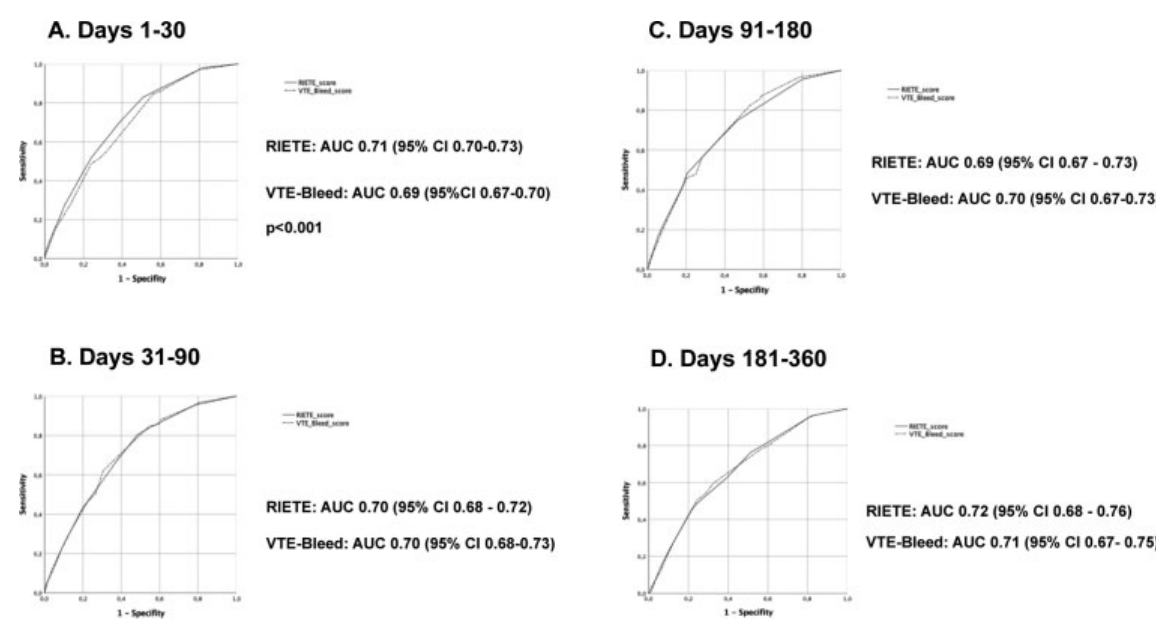
Fig. 1 Receiver operating characteristic (ROC) curve for major bleeding in patients treated with